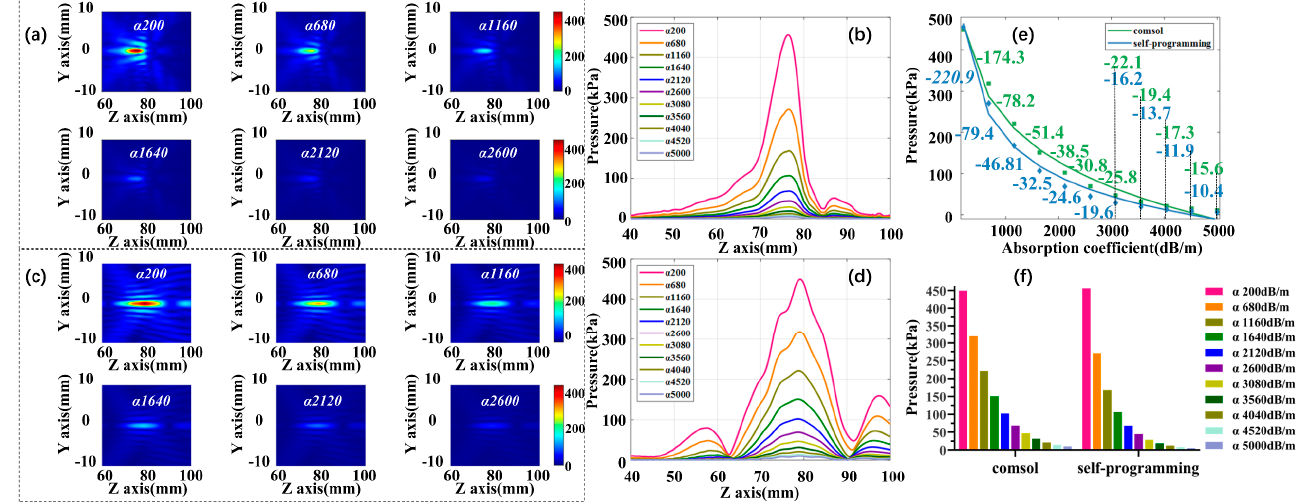
Figure 10. The effect of absorption coefficient varied on focus acoustic pressure. ( a ) Self-programming focus acoustic pressure field; ( b ) self-programming acoustic axis acoustic pressure curve; ( c ) COMSOL focus acoustic pressure field; ( d ) COMSOL acoustic axis acoustic pressure curve; ( e ) focus acoustic pressure variation fitting curves for both simulations; ( f ) histogram of focus acoustic pressure variation for both simulations.